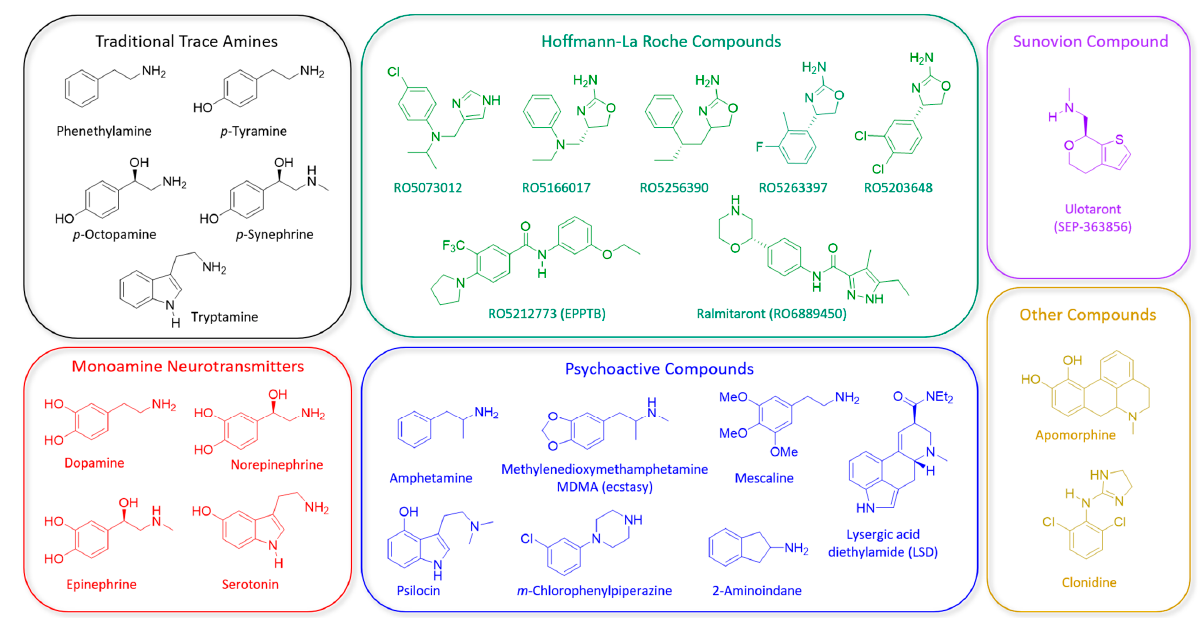
Figure 1. Structures of notable endogenous and synthetic TAAR1 ligands.